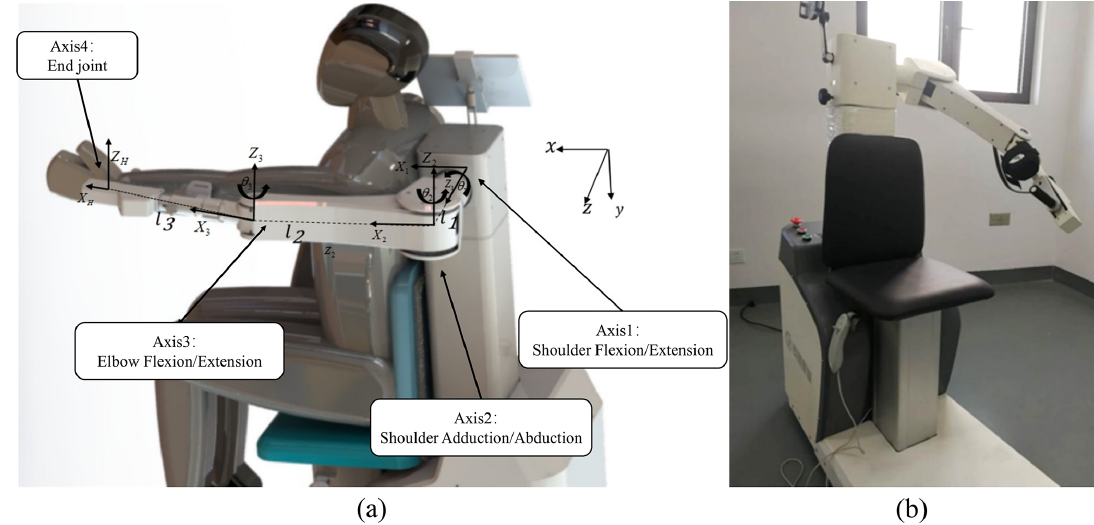
Figure 1. 3-DOF upper limb rehabilitation robot with the center-driven mechanism. (a) Frame. (b) Prototype.